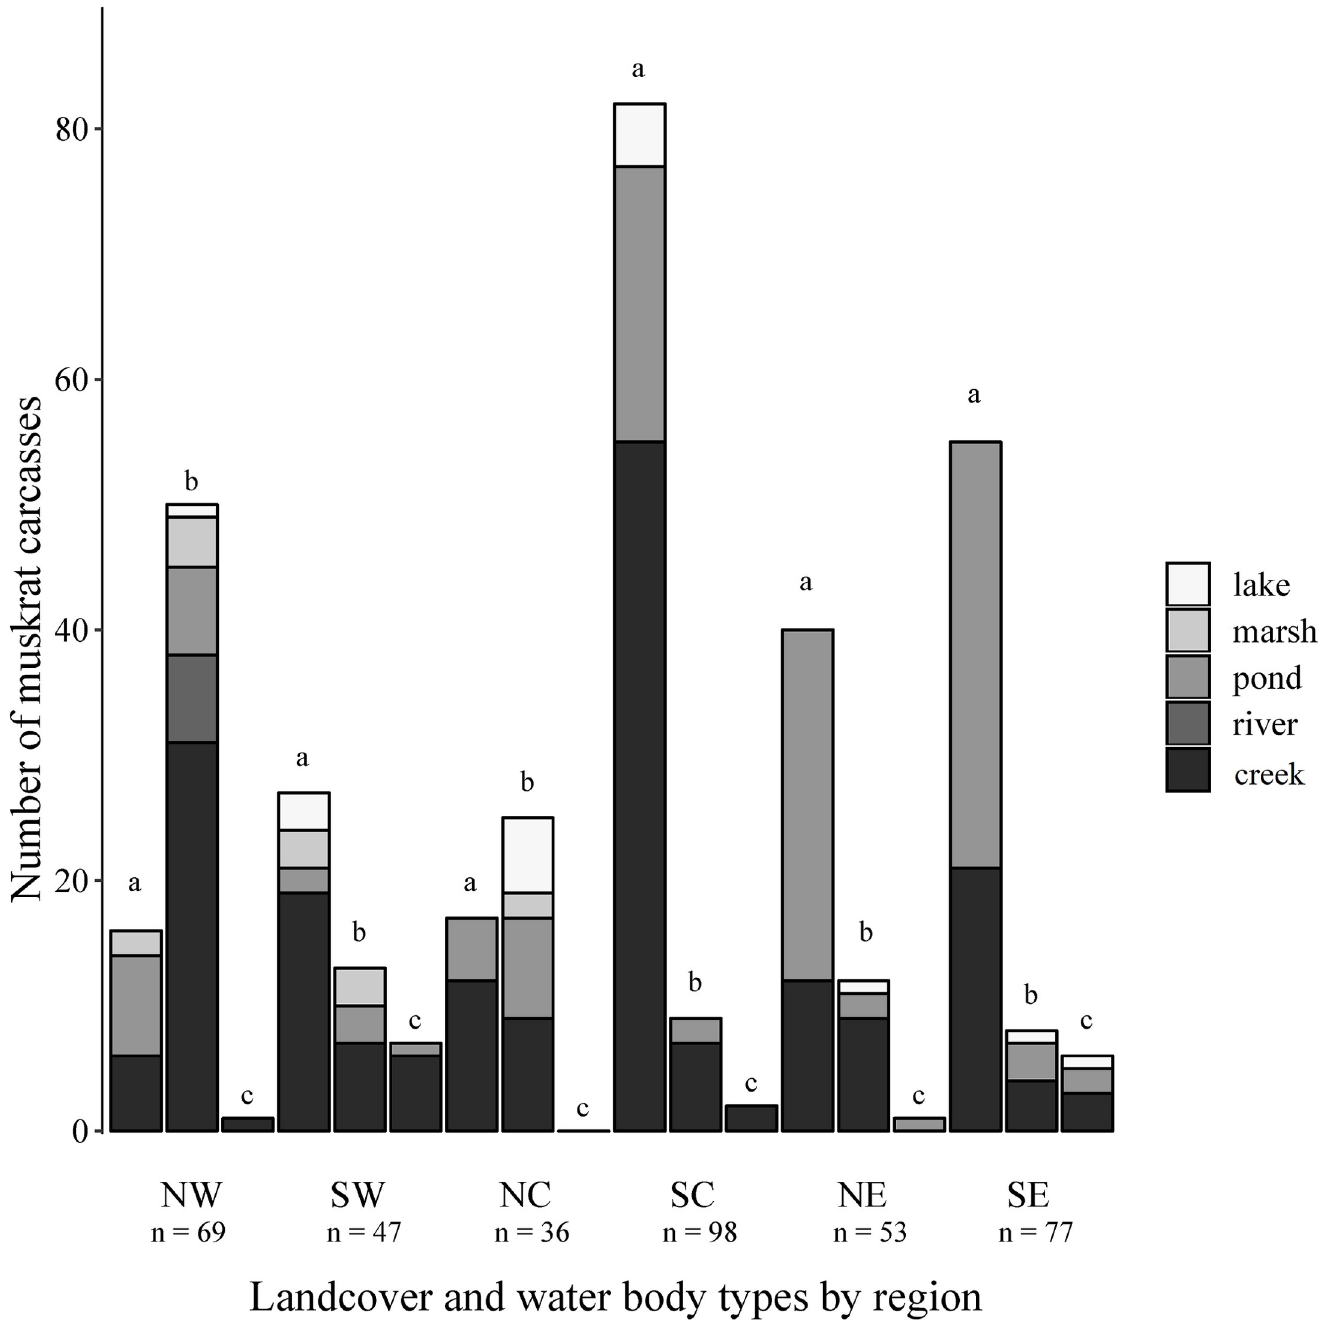
Fig 2. Distribution of landcover type and water body type where muskrats ( Ondatra zibethicus ) were collected in Pennsylvania, USA, 2018–2019. Landcover types were designated by bars within regions and included: agriculture (a), forest (b), and urban (c). Regions within Pennsylvania are Northwest (NW), Southwest (SW), Northcentral (NC), Southcentral (SC), Northeast (NE), and Southeast (SE). https://doi.org/10.1371/journal.pone.0260987.g002 and urban (n = 17). We were unable to determine specific water body type or land-cover type for 15/380 muskrats due to lack of information provided by the trapper. The average carcass weight was 1026.85 g ( SE = 10.33) with the most variation in weight in the SC region (Fig 3).